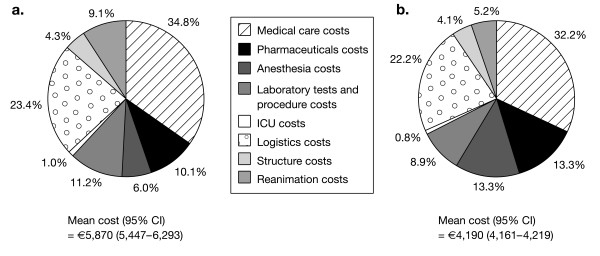
Cost breakdown in public hospitals aamong arthritis patients (a) with anemia or (b) without anemia. aNot available for private hospitals. ICU, intensive care unit.